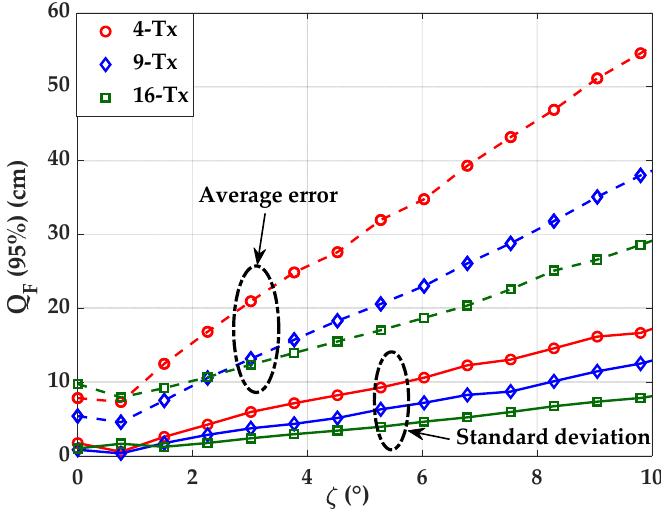
Figure 11. Comparison of positioning error for different Txs and ζ .